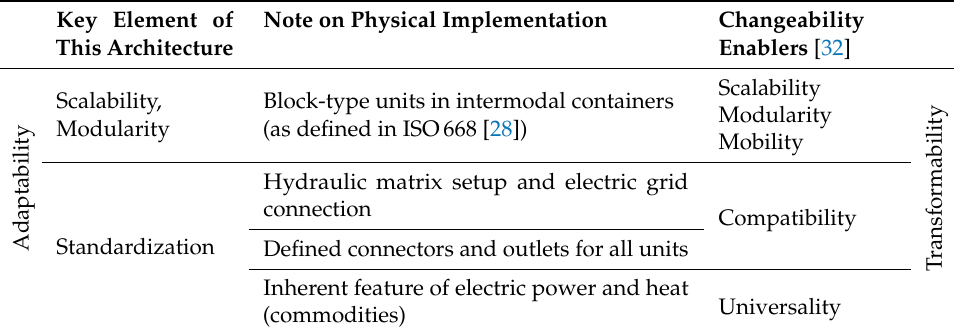
Table 1. Analogy to factory transformability features.